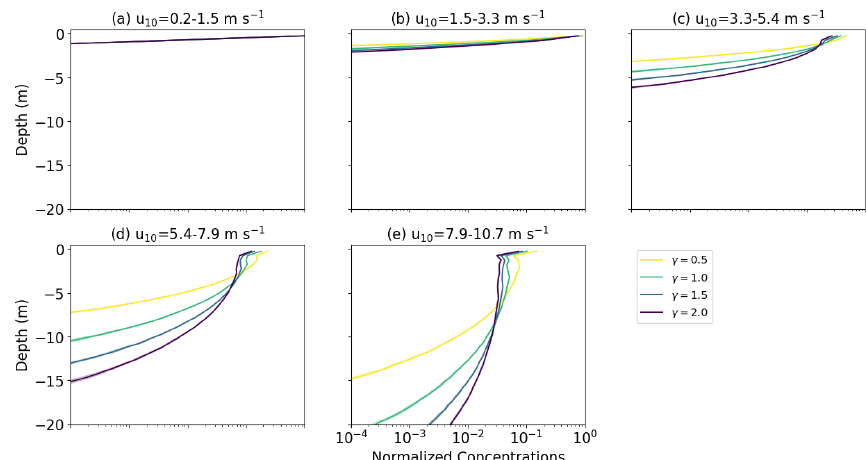
Figure E2. Vertical concentrations of buoyant particles for KPP diffusion under varying wind conditions with w r = 0 . 03ms − 1 . The SWB diffusion profile is calculated with γ ∈ [ 0 . 5 , 1 . 0 , 1 . 5 , 2 . 0 ] . The grey markers indicate field measurements, with darker shades indicating more measurements, while the binned field measurement average and standard deviation are shown by the black markers. Shading around the profiles indicates the profile’s standard deviation at each depth level.